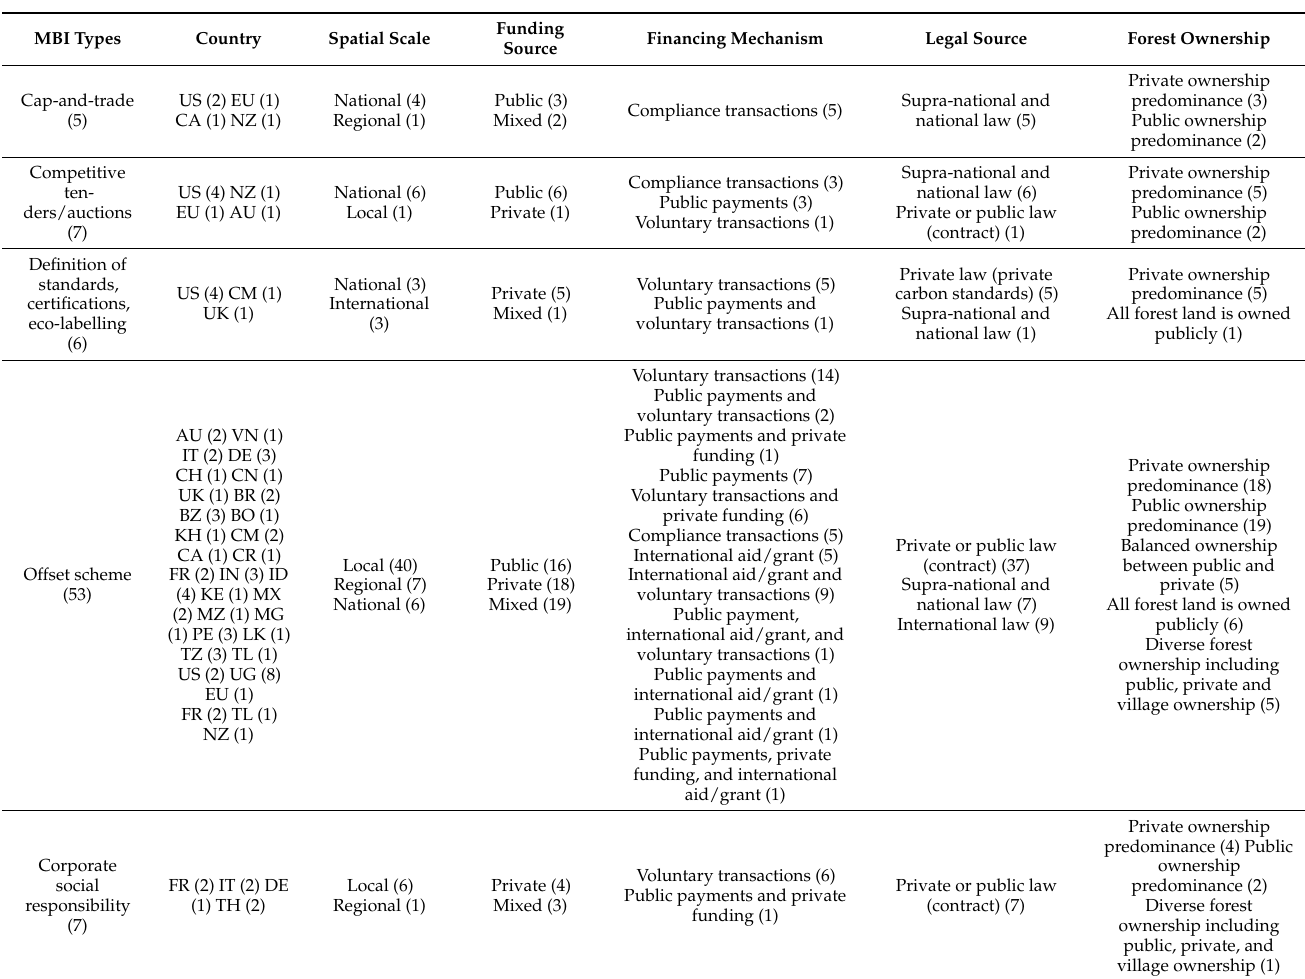
Table 3. Description of policy design features for market-based instruments identified in the literature review (number in parentheses represents the number of mechanisms with corresponding